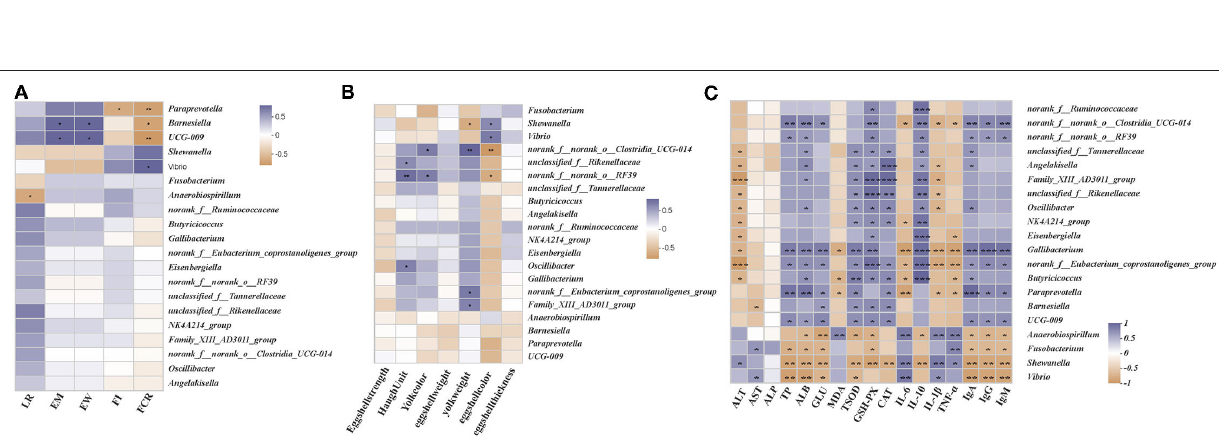
FIGURE 6 | Effect of dietary PNE supplementation on gut microbial composition. (A) Shannon index, (B) Simpson richness, (C) ACE diversity, and (D) Chao1 richness. (E) Principal coordinate analysis (PCoA) plots were assessed via analysis of similarities among the treatments. (F) Relative abundances of bacterial phyla in these groups. (G) Relative abundance of bacterial genera in these groups. (H) Linear discriminant analysis effect size (LEfSe) analysis was used to identify the differential genera between the PNE100 and control (CON) groups.